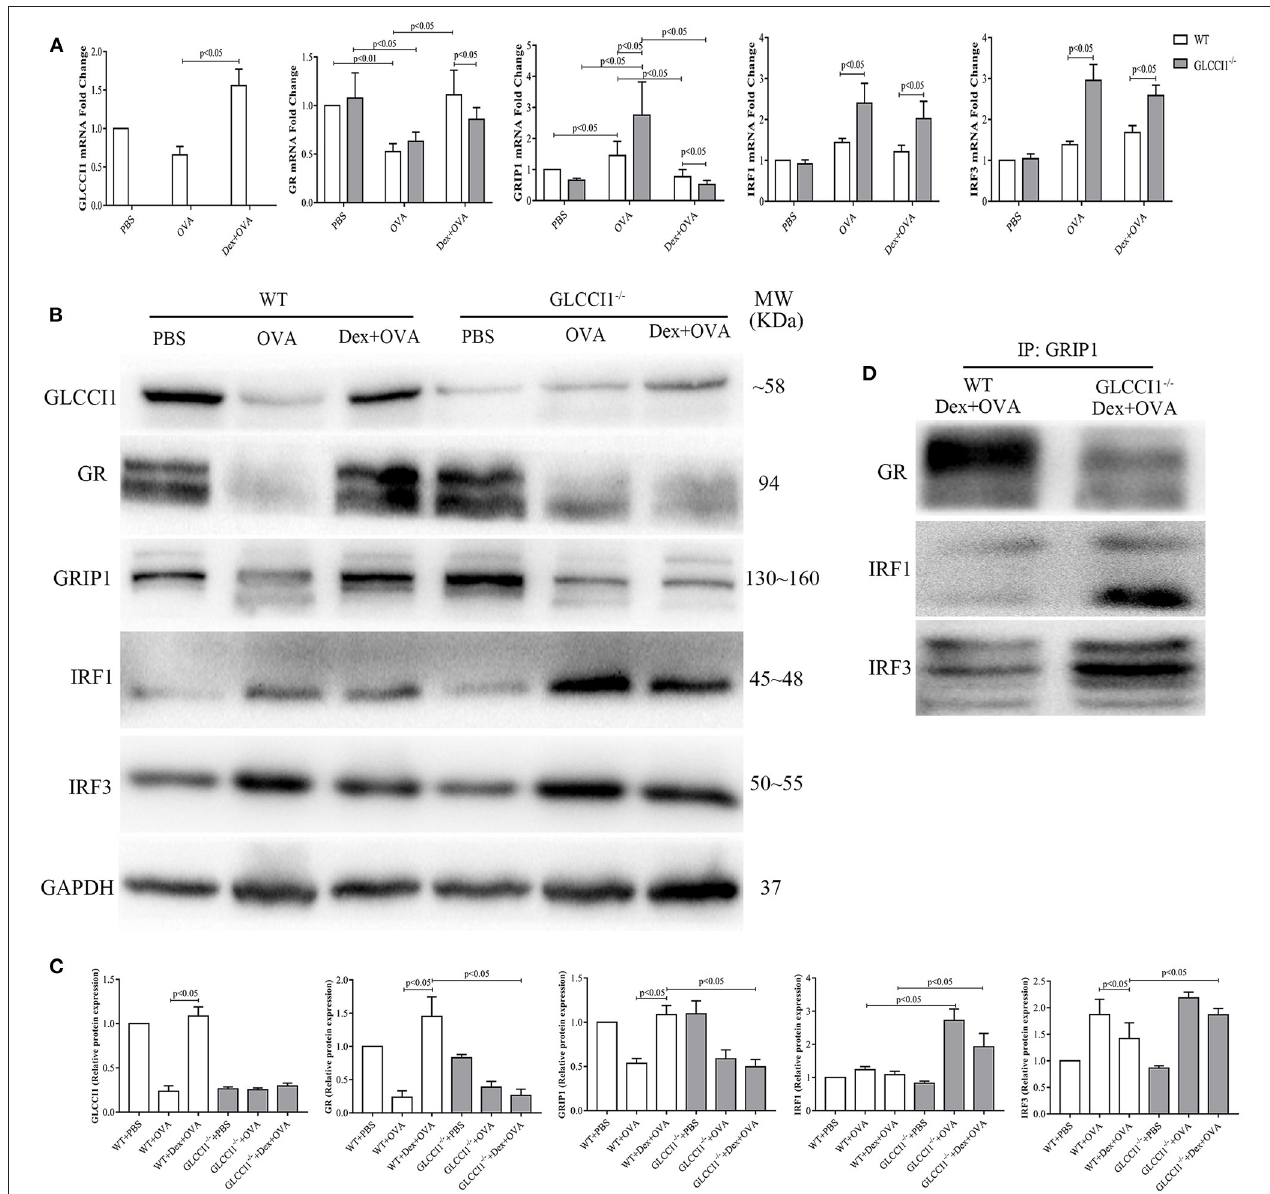
FIGURE 3 | GLCCI1 deficiency suppresses GR-GRIP1 binding through increasing the recruitment of GRIP1 to IRF1 and IRF3 in OVA-induced asthmatic mice. (A) RT-PCR analysis of GLCCI1, GR, GRIP1, IRF1, and IRF3 mRNA expression in the lungs of mice from different groups. Representative images of protein expression detected by WB (B) and relative protein levels (C) of GLCCI1, GR, GRIP1, IRF1, and IRF3 in the lungs of mice in different groups. (D) Anti-GRIP1 mAb was used to capture GR, IRF1, and IRF3 in lung tissues from WT and GLCCI1 − / − Dex-treated mice to detect the individual binding of GRIP1 with GR, IRF1, and IRF3. Data are presented as the mean ± SEM, n = 6 mice per group. Independent groups were evaluated by Student’s t -test, and intergroup differences as determined one-way ANOVA followed by LSD